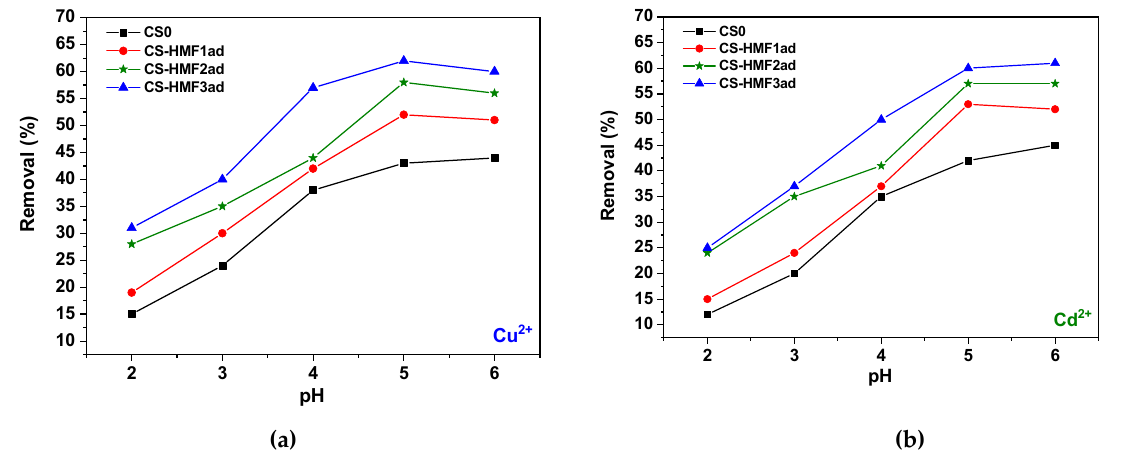
Figure 5. E ff ect of pH on the removal of (a) Cu 2 + and (b) Cd 2 + by CSO, CSO-HMF1ad, CSO-HMF2ad, Figure 5. Effect of pH on the removal of (a) Cu 2+ and (b) Cd 2+ by CSO, CSO-HMF1ad, CSO-HMF2ad, CSO-HMF3ad. Experimental conditions: C 0 = 100 mg / L, V = 20 mL, N = 160 rpm, T = 25 ◦ C, t = 24 h, CSO-HMF3ad. Experimental conditions: C 0 = 100 mg/L, V = 20 mL, N = 160 rpm, T = 25 °C, t = 24 h, m m = 0.02 = 0.02 g.